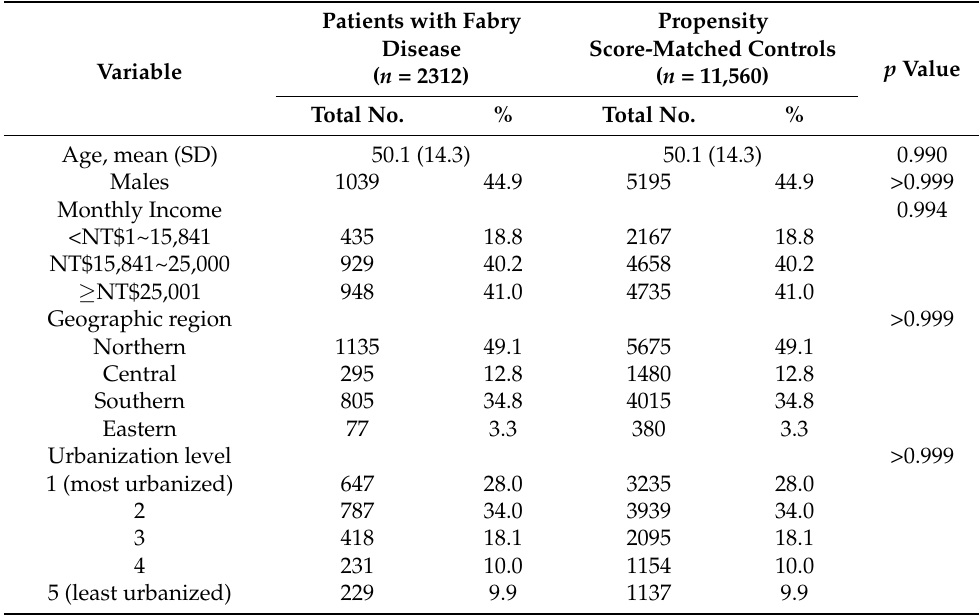
Table 1. Demographic characteristics of persons with Fabry disease and comparison patients ( n = 13,872).